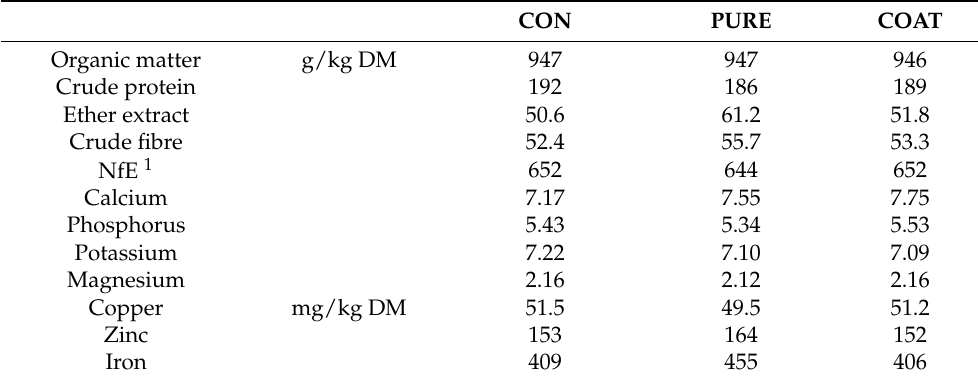
Table 2. Chemical composition of the three experimental diets CON (control diet), PURE (diet containing pure charcoal) and COAT (diet containing coated